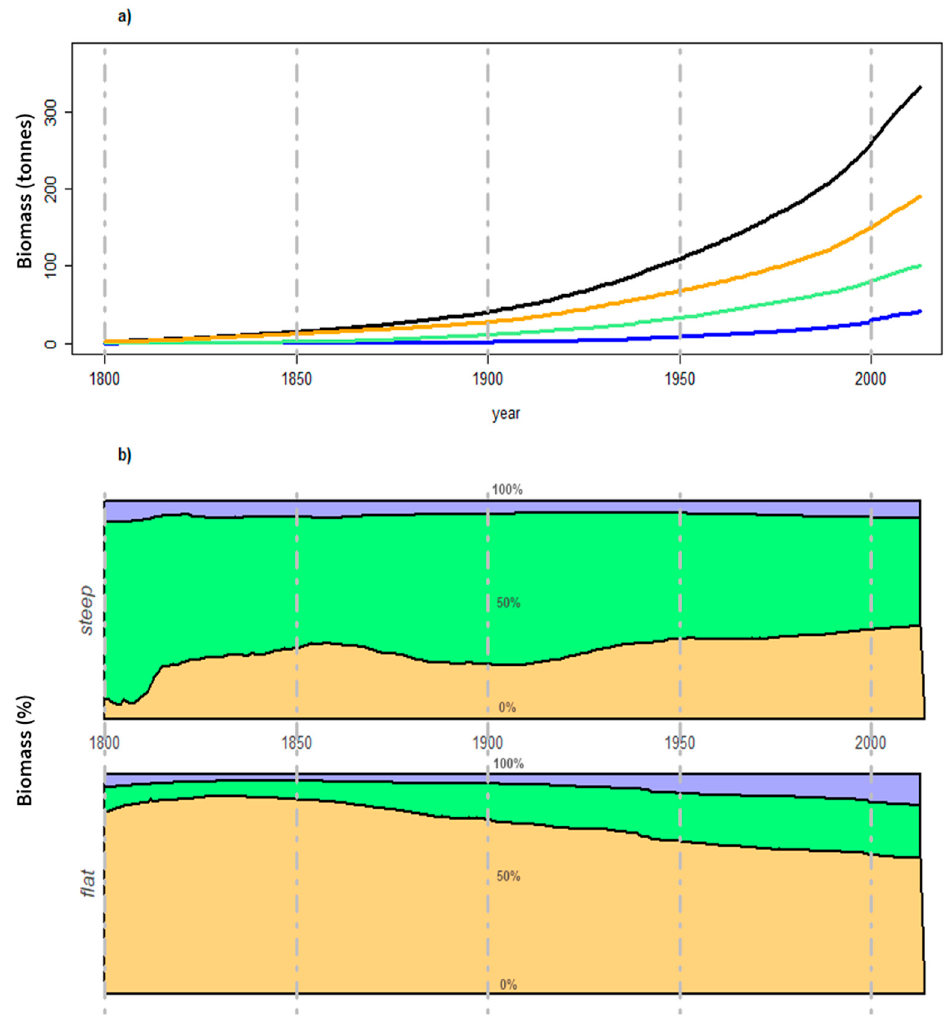
Figure 5. Biomass (tonnes) reconstruction based on tree rings ( a ) at the stand level (continuous) and ( b ) the relative abundance of the main species for the steepest (dotted) and flattest (continuous) sectors in the Penteleu 1 ha plot (black), beech (orange), silver fir (green), Norway spruce (blue) .